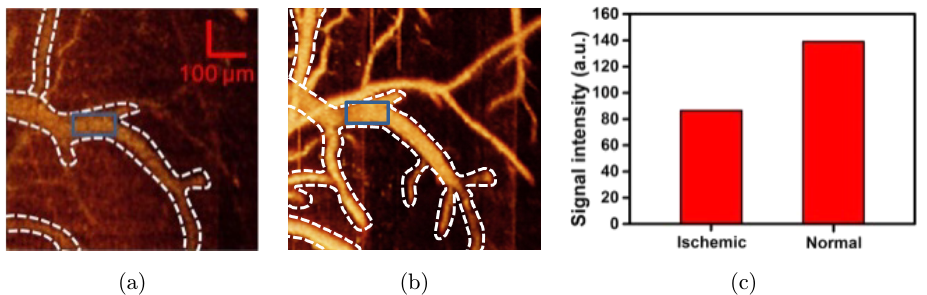
Fig. 9. 3D OCT images of (a) ischemic and (b) normal cerebral blood vessels in mice; (c) OCT signal intensity of ROIs which were marked with blue solid rectangles in (a) and